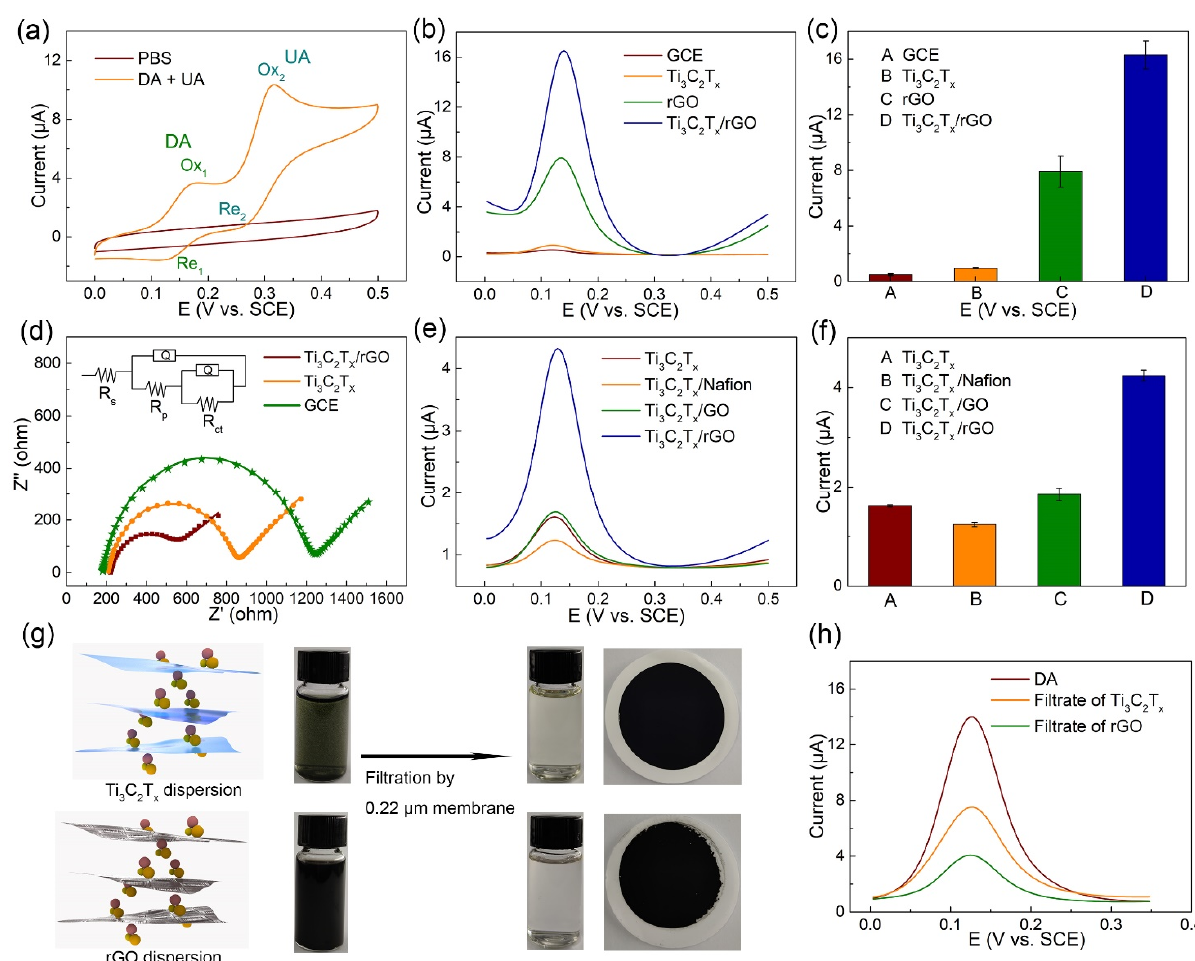
Figure 3. ( a ) CV of Ti 3 C 2 T x /rGO electrode with and without 10 µ M DA and 30 µ M UA in PBS. ( b ) DPV curves of various modified electrodes with 10 µ M DA in PBS. ( c ) The corresponding current value of ( b ). ( d ) Impedance plots of various modified electrodes with 10 mM [Fe(CN) 6 ] 3 − /4 − . ( e ) Performance comparison of DPV curves on various materials modified Ti 3 C 2 T x electrode with 10 µ M DA in PBS. ( f ) The corresponding current value of ( e ). ( g ) Schematic diagram of DA adsorption in Ti 3 C 2 T x and rGO dispersion. ( h ) DPV curves of DA adsorption performance. To further investigate the synergistic effect of the Ti 3 C 2 T x /rGO nanocomposite, GO and Nafion were taken as the coating layer hybrid with Ti 3 C 2 T x and rGO as the coating layer hybridize with the Au electrode instead of the Ti 3 C 2 T x electrode, in comparison with the Ti 3 C 2 T x /rGO nanocomposite modified electrode. As shown in Figure 3e,f, the current intensity on the Ti 3 C 2 T x /Nafion electrode was lower than that of the Ti 3 C 2 T x electrode. This indicates that Nafion as an electric material is not suitable for hybridizing with Ti 3 C 2 T x to DA electrochemical reaction. The current intensity of the Ti 3 C 2 T x /rGO electrode was higher than of the Ti 3 C 2 T x /GO electrode, indicating that less oxygen-containing groups of rGO with better electrical conductivity exhibited greater facilitation of electron transfer reaction of DA. Interestingly, the current intensity of Au electrode/rGO electrode was lower than that of the Ti 3 C 2 T x /rGO electrode, demonstrating the advantage of the porous Ti 3 C 2 T x electrode to the smooth Au electrode towards DA electrochemical reaction, as dis- played in Figure S2. To further reveal the superior electrochemical performance of rGO to Ti 3 C 2 T x , a comparison experiment of DA adsorption performance was conducted between Ti 3 C 2 T x and rGO water dispersions, as shown in Figure 3g. Ti 3 C 2 T x and rGO water disper- sions containing 100 μ M DA were prepared with sonification. After filtration by 0.22 μ M membrane, the filtrates of Ti 3 C 2 T x and rGO dispersions both became much more transpar- ent, and the colors of both film membranes were much darker. The result demonstrates